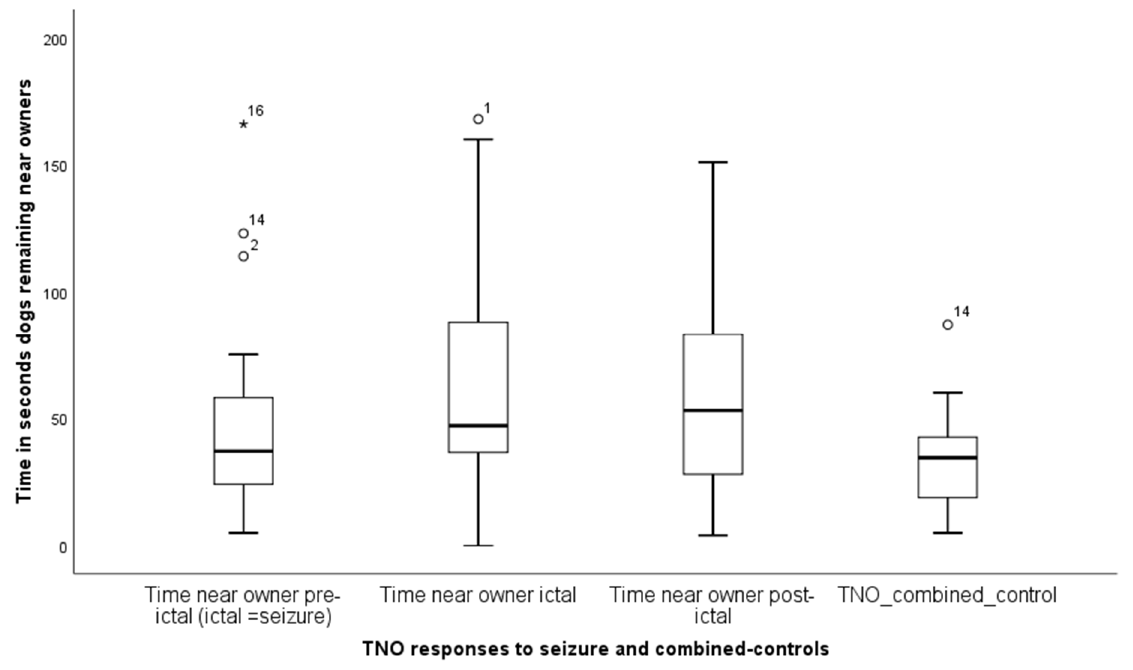
Figure 3. A box and whisker plot to show the times when the dogs remained in close proximity to their owners (one meter), measured across the four odour deliveries of seizure and combined control. The asterisks and circles represent outliers, that fall more than 1.5 times the interquartile range above the third quartile or below the first